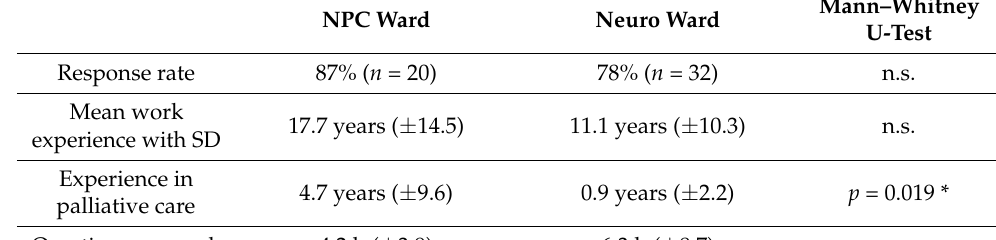
Mann–Whitney U-Test